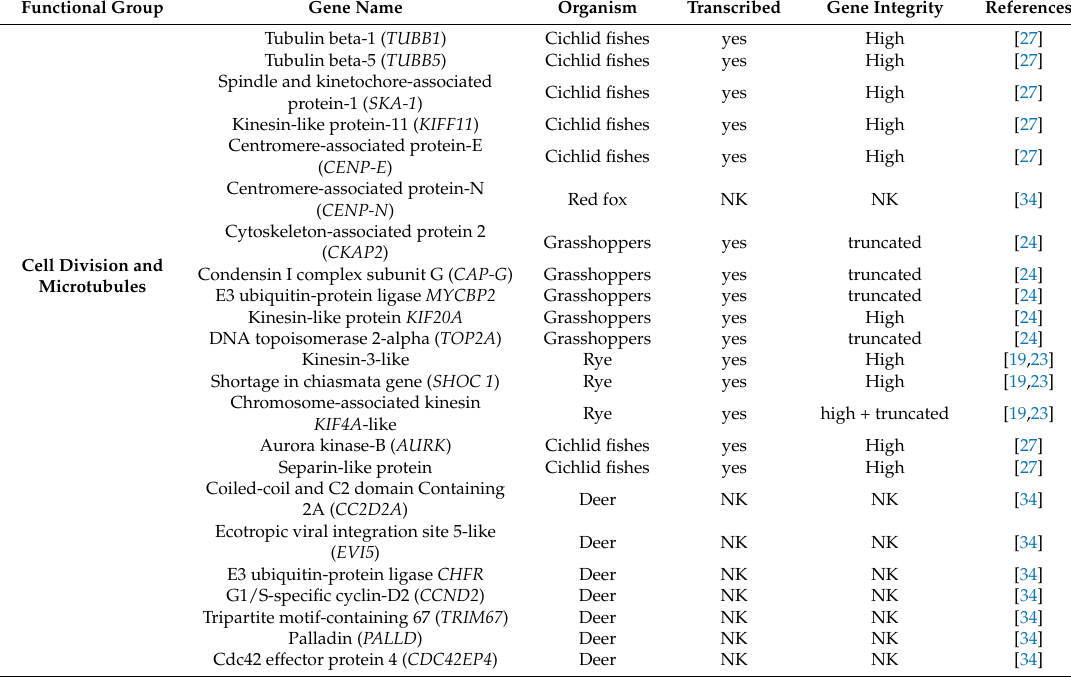
Table 1. Protein-coding genes located on B chromosomes in different species. (NK = not